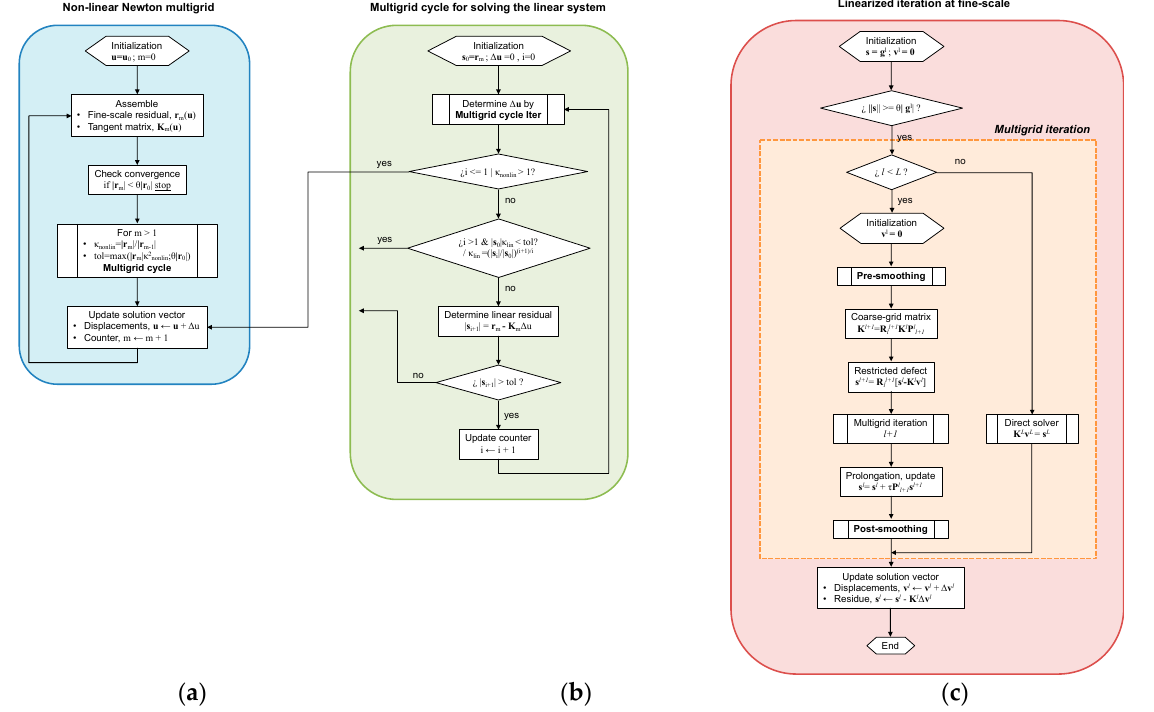
Figure 18. Multigrid schemes: non-linear Newton multigrid ( a ) calls a nested algorithm for solving the linear problem ( b ) and, at the same time, this calls for a linearized iteration at the fine-scale ( c ). Algorithm adapted from [26].